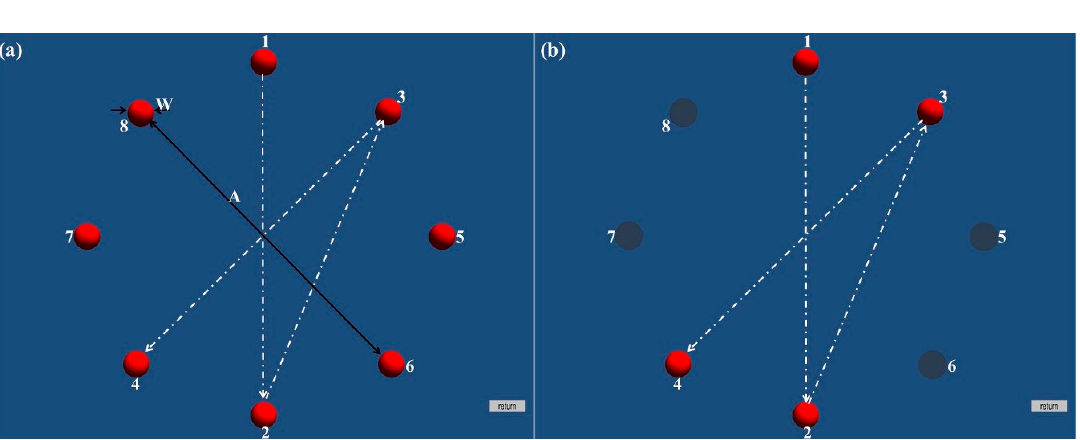
Figure 2. Illustration of the experimental task. ( a ) Eight virtual spherical targets appeared one at a time in sequence, with target width (W) and amplitude of inter-target distances (A), and ( b ) the sequence of pointing trials for the first four targets.